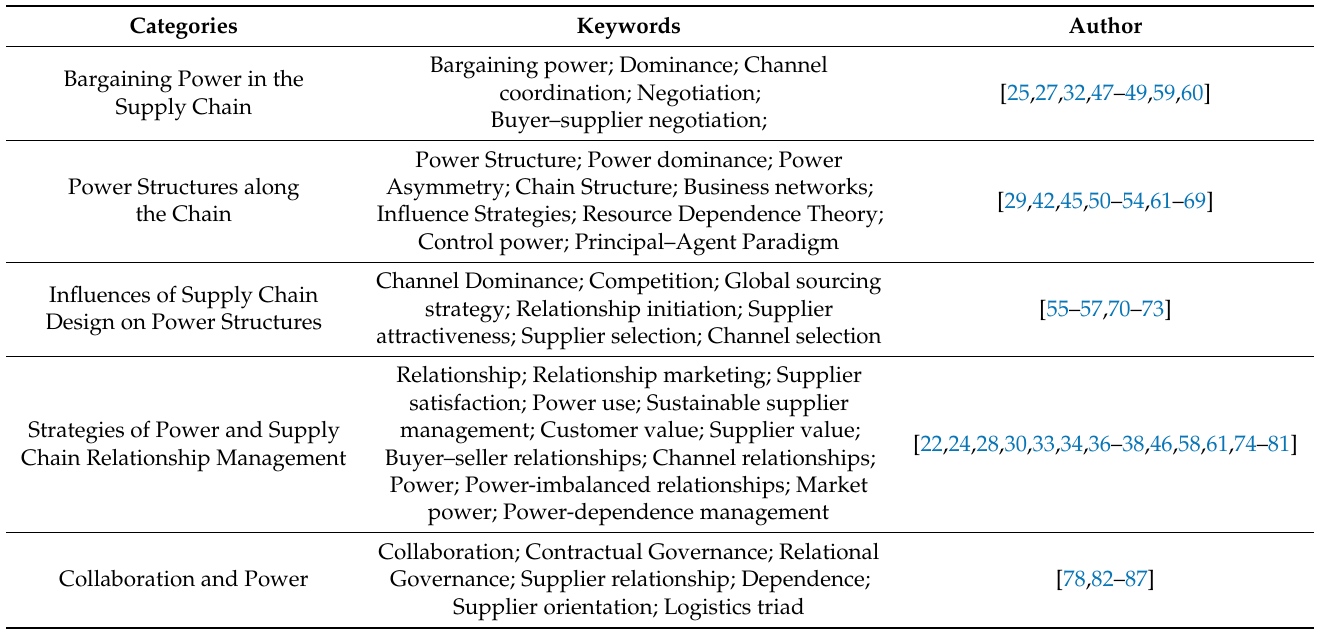
Table 3. Categorization of the research